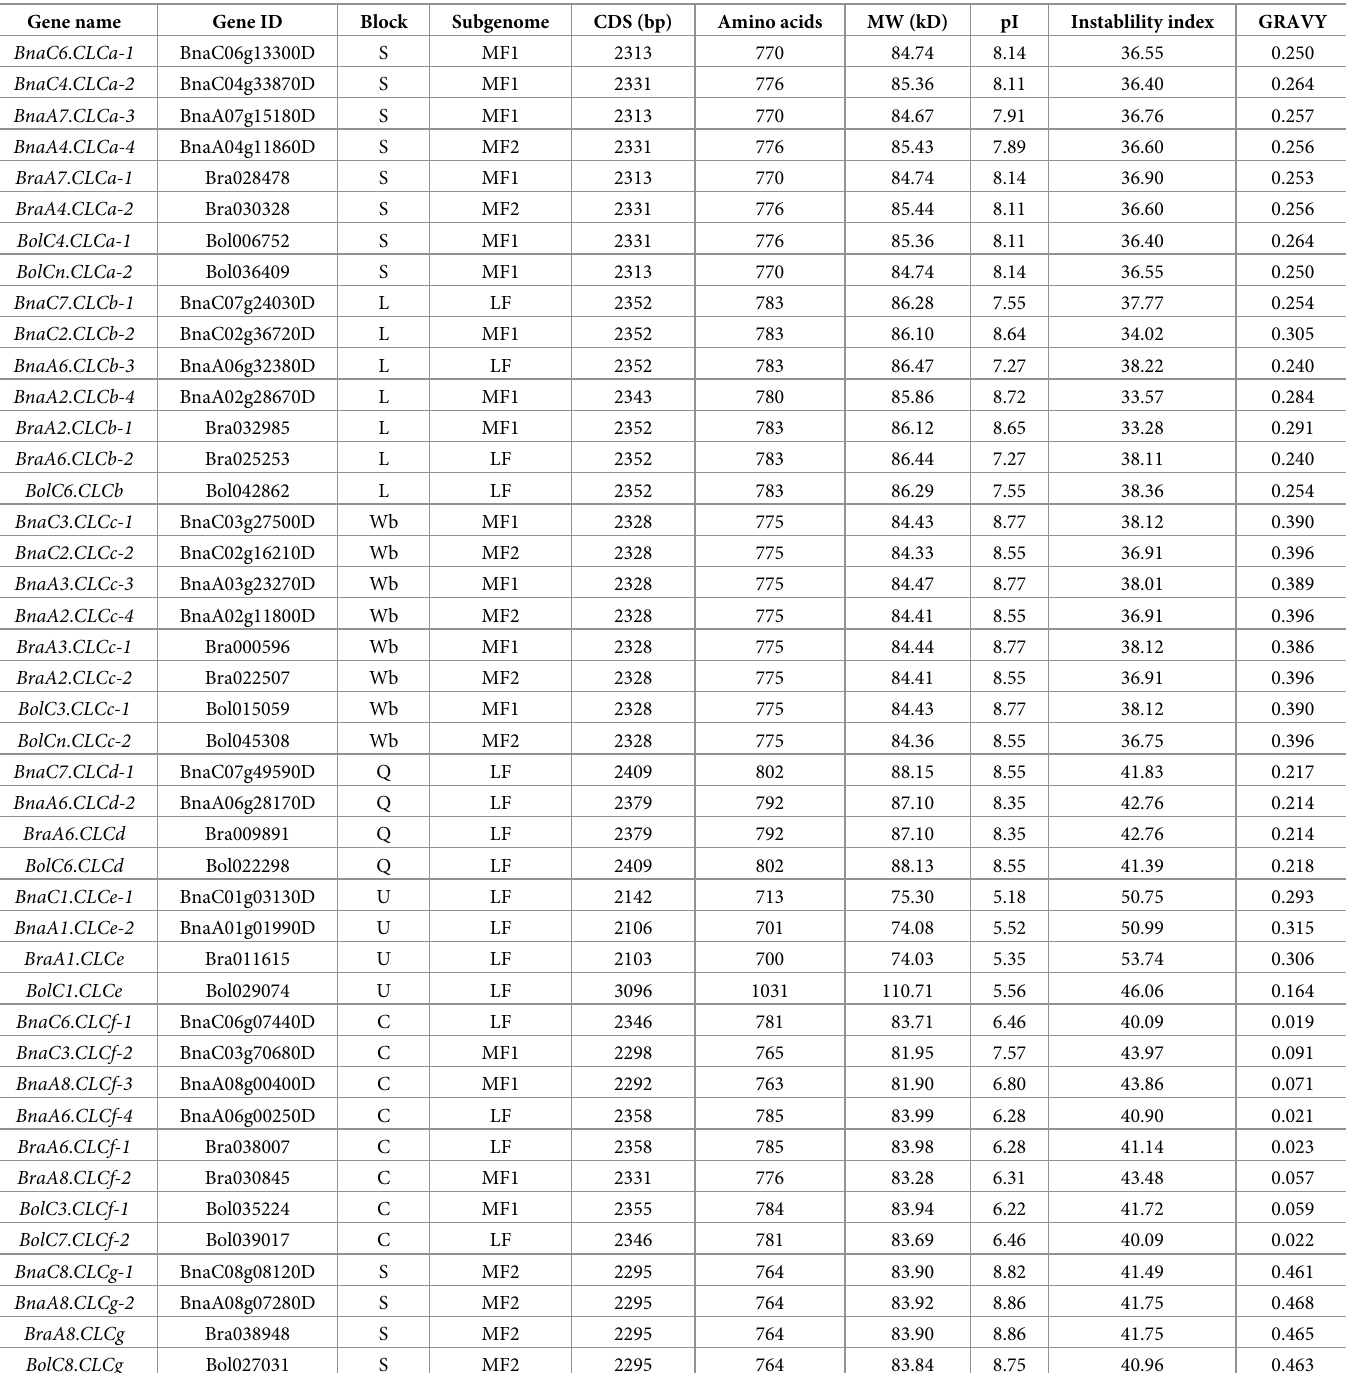
Table 1. Molecular characterization of the BnaCLC family proteins in Brassica crops ( B . rapa , B . oleracea and B . napus